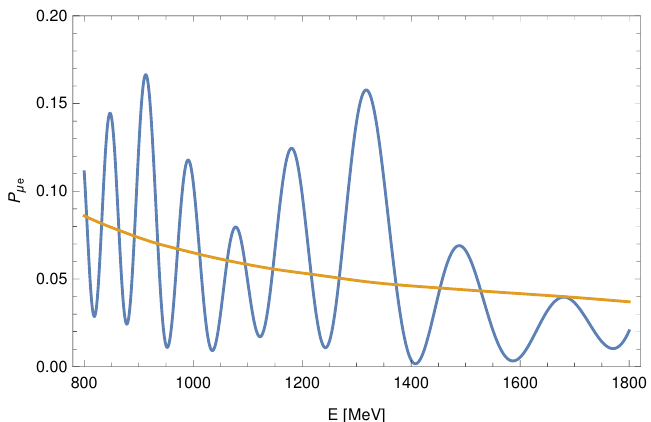
Figure 11 . Oscillation probabilities for (cid:23) (cid:22) ! (cid:23) e transitions for the CP-phase (cid:14) = (cid:25)= 2 as a function of neutrino energy (in MeV) and azimuthal angle (cid:18) = (cid:25)= 10. Blue line: P (cid:22)e ( E; (cid:18) ), green line: (cid:22) P (cid:22)e ( E; (cid:18) ). Normal mass ordering is